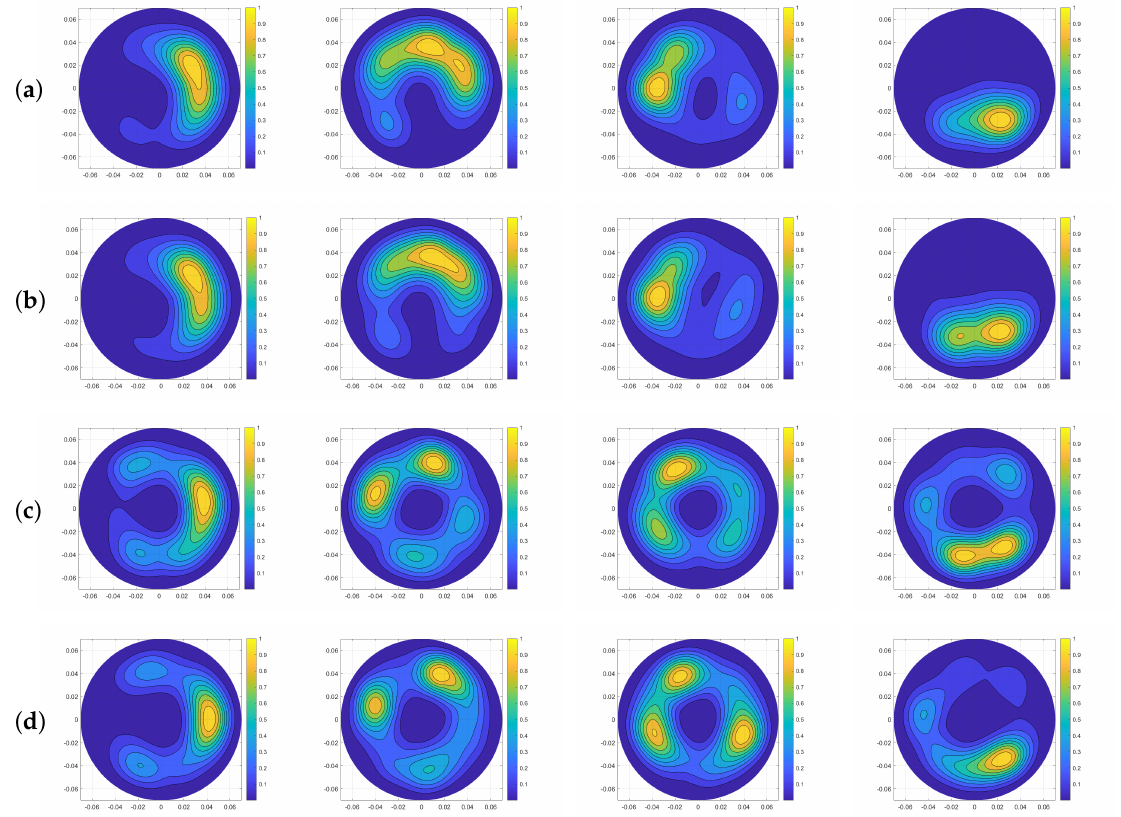
Figure 3. Combination of 5 transmitting position triplets using Rotation Subtraction (RS), Local Average Subtraction (LAS), Differential Symmetric Receiver Type (DSR), and Summed Symmetric Differential (SSD) artefact removal methods for inclusion positioned at 0 ◦ , 90 ◦ , 180 ◦ , and 270 ◦ , respectively. Microwave images obtained using ( a ) RS, ( b ) LAS, ( c ) DSR, and ( d ) SSD artefact removal methods.